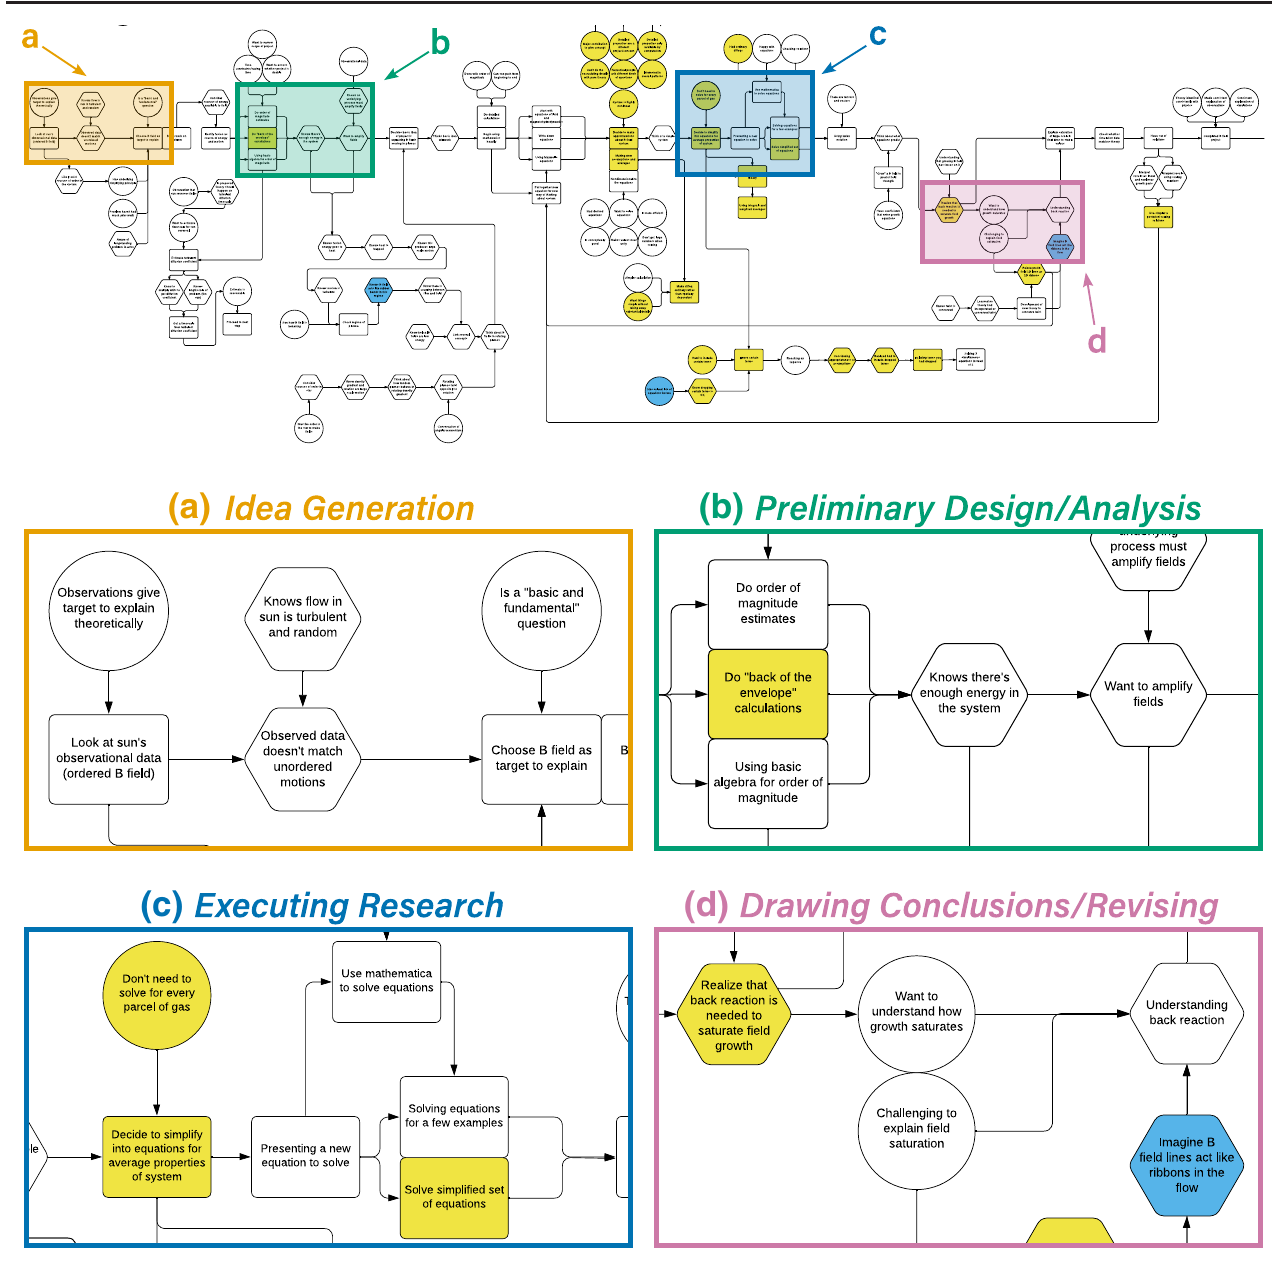
FIG. 3. A sample process diagram that was generated using the actions, cues, and sensemaking process codes, with callouts indicating representative examples of the different subprocesses. Rectangles represented actions, circles represented cues, and hexagons represented instances of sensemaking. Shapes shaded yellow indicate that they are related to assumptions while blue indicates a relation to analogy. Visually, arrows connecting the action-cue-sensemaking bubbles point in all directions on the diagram, indicating that theorists frequently jump between different points in their overall process. In this specific diagram, the prevalence of yellow shapes illustrates that this theorist frequently described aspects of their process related to making effective assumptions. Figure generated with Lucidchart